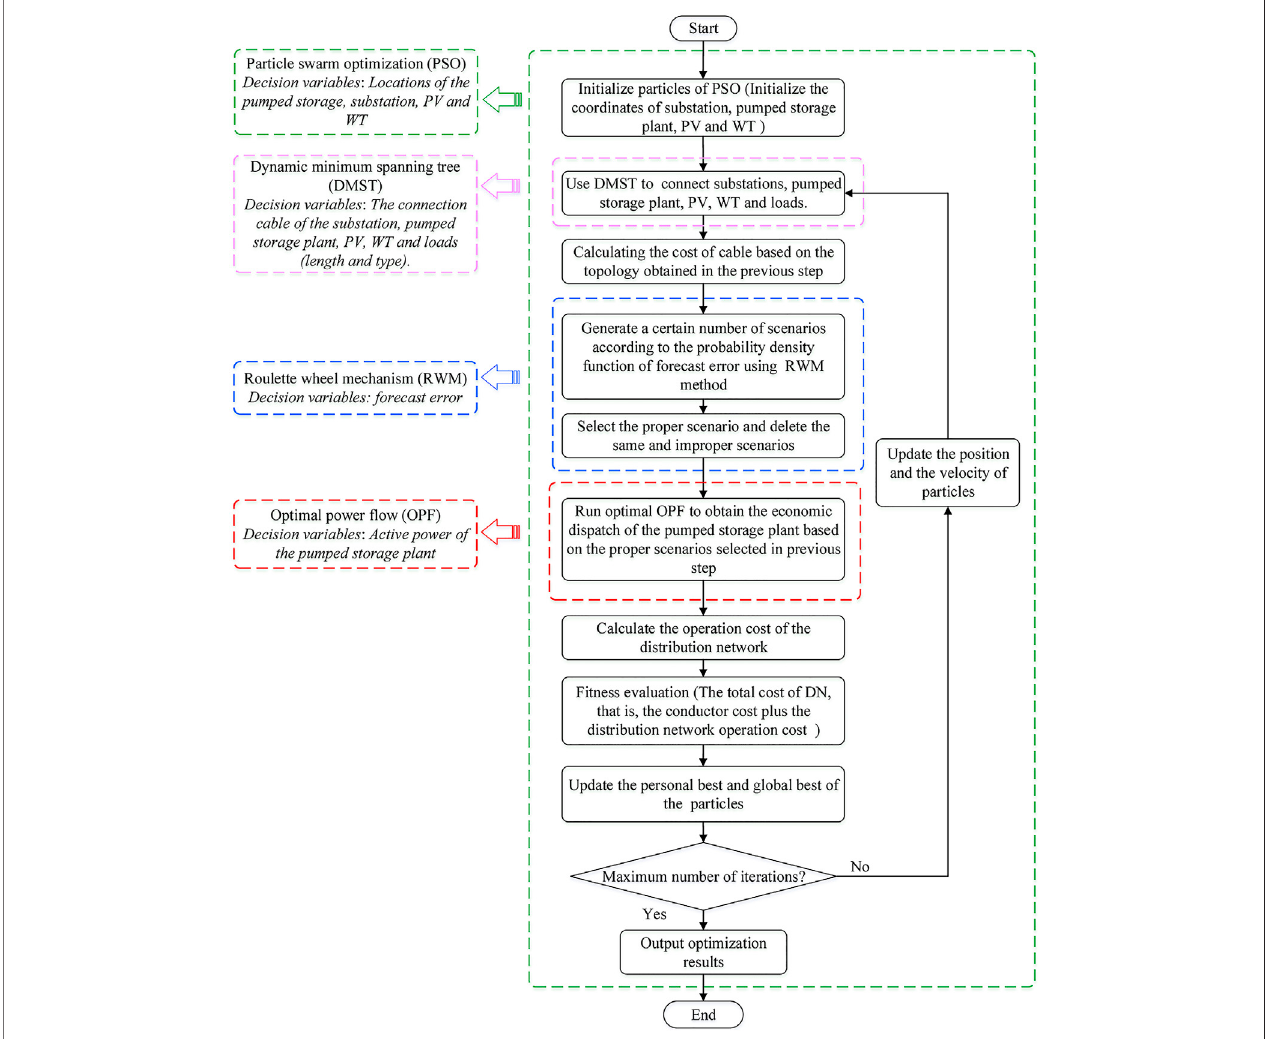
FIGURE 3 | Flowchart of the proposed bi-layer planning